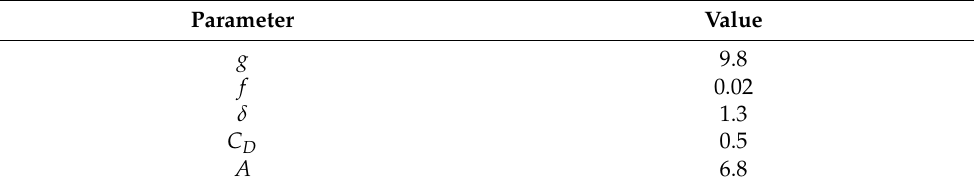
Table 2. Parameter values.